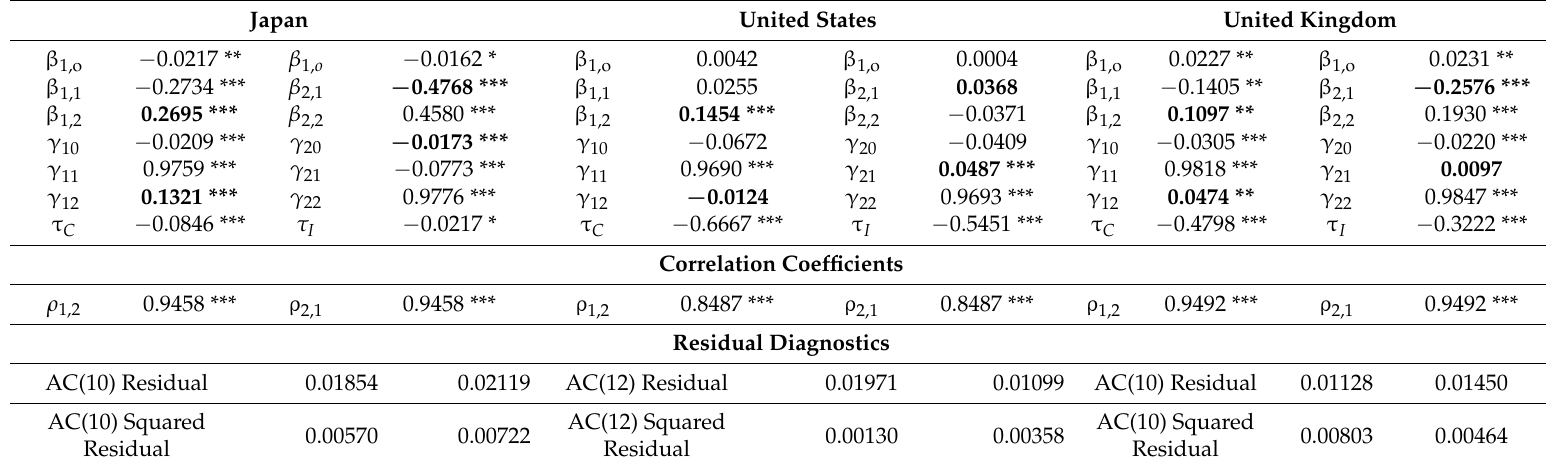
Table A1. Estimation from the bivariate VAR-EGARCH